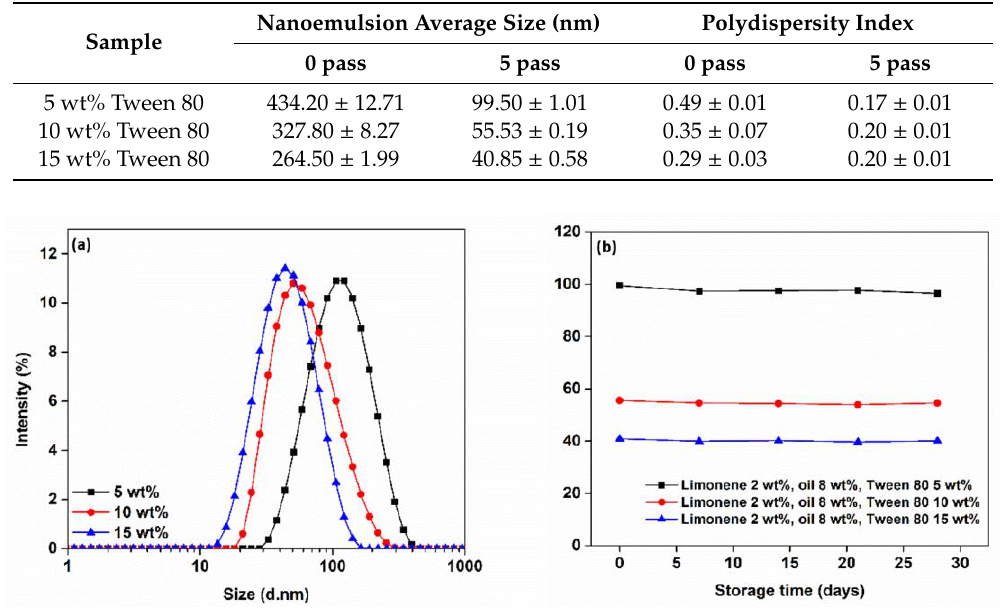
Figure 6. Emulsifier concentration effect on ( a ) nanoemulsion size distribution, and ( b ) nanoemulsion stability.